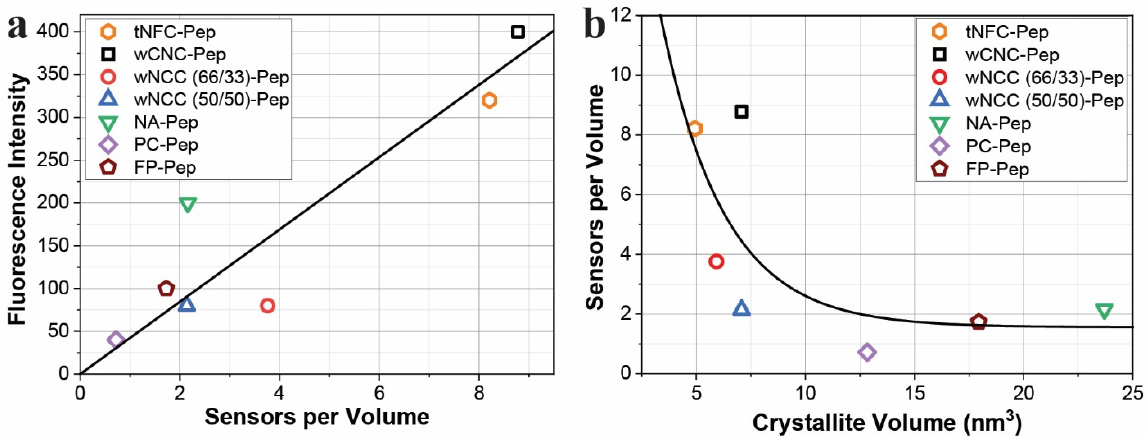
Figure 3. ( a ) Fluorescence intensity based on the number of sensors per crystallite volume, and ( b ) sensors per crystallite volume as a function of the calculated crystallite volume.